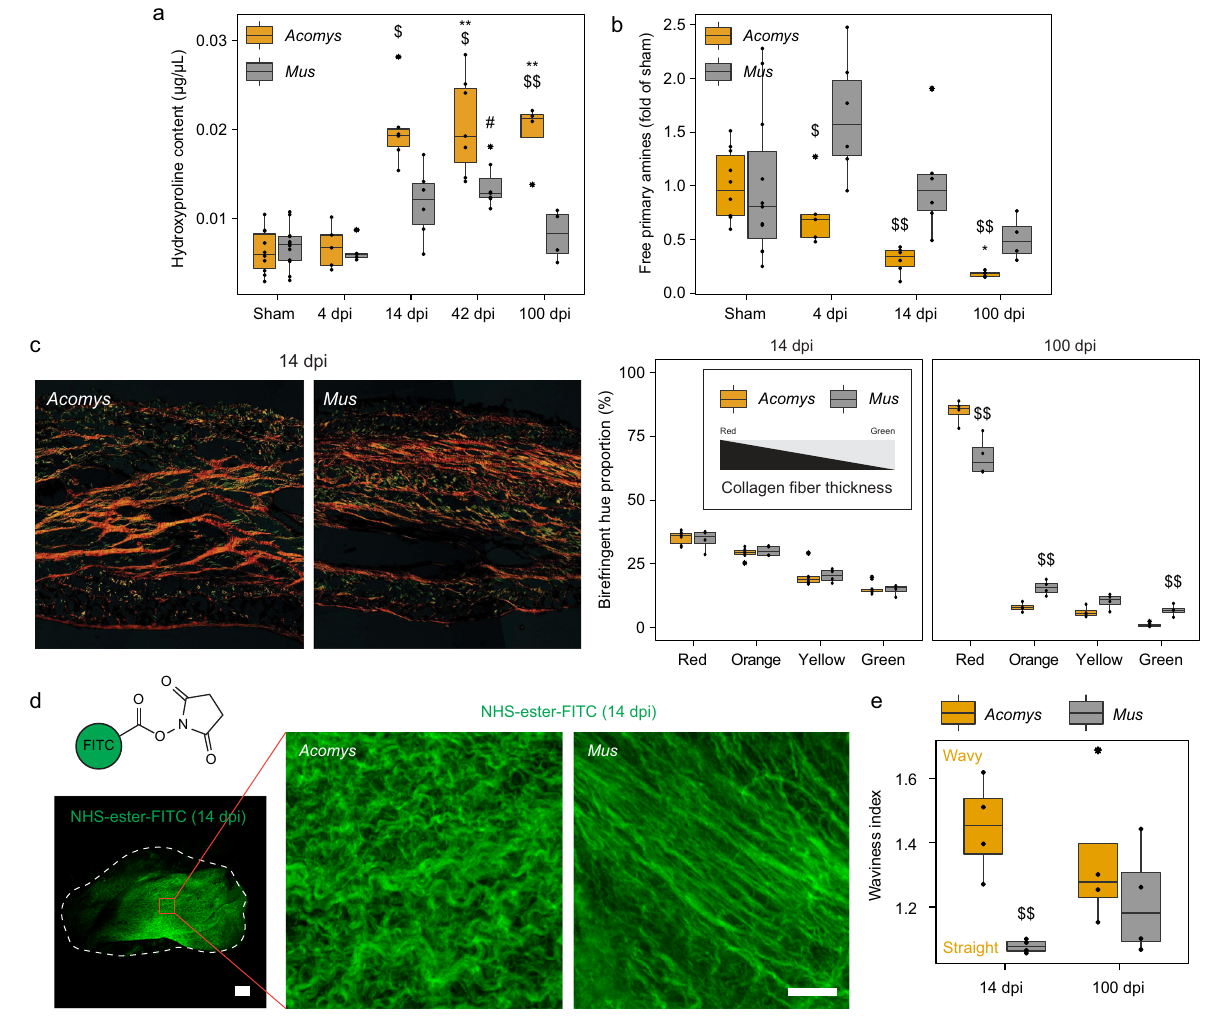
Fig. 3 Scar organization is different in Acomys and Mus hearts. a Hydroxyproline assay from whole heart ventricle homogenates. b TNBSA assay from whole heart ventricle homogenates, normalized to total collagen content (hydroxyproline assay) and sham-control. c Polarized light imaging of injured hearts to analyze collagen fi ber thickness. Left panel are representative images of the scar center (14 dpi) with the corresponding quanti fi cation on the right. d N-hydroxysuccinimide ester labeling and whole-mount imaging of injured hearts (14 dpi). Scale bar = 200 µm (overview) and 50 µm (inlet). e Waviness of individual collagen fi bers, quanti fi ed from ( d ). a , b , c , e Two-way mixed ANOVA followed by Bonferroni post hoc test. For all comparisons: * is signi fi cant compared to Acomys -sham, # compared to Mus -sham, $ is signi fi cant in an inter-species comparison of the same time point (e.g. 100 days to 100 days). * is p < 0.05, ** is p < 0.01, and *** is p < 0.001. Box plots represent the median, interquartile range (IQR), minimum (25th percentile – 1.5 × IQR), and maximum (75th percentile – 1.5 ×